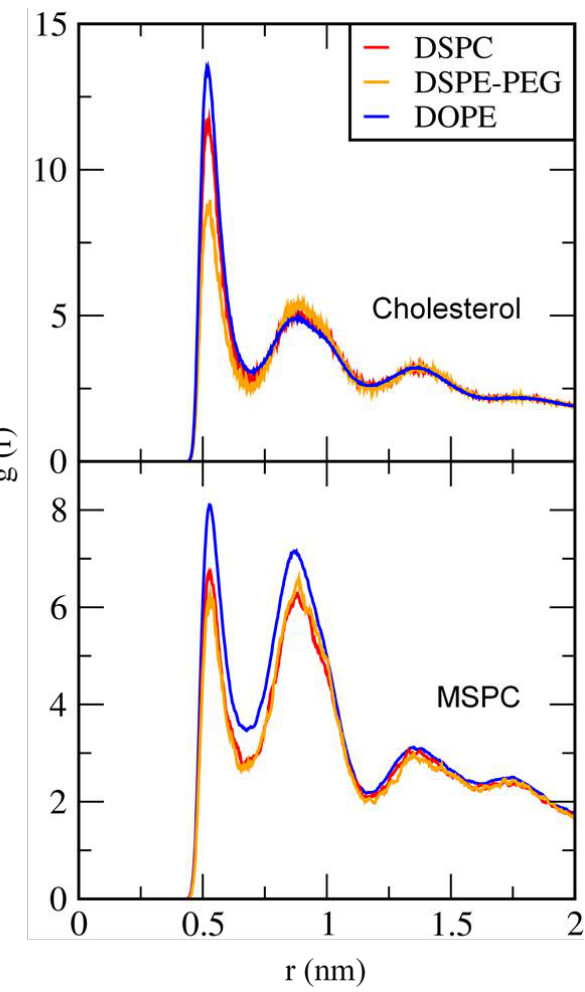
Figure 6. Radial distribution functions (RDFs) of DSPC, DSPE-PEG, and DOPE with respect to cholesterol ( top ) and MSPC ( bottom ).